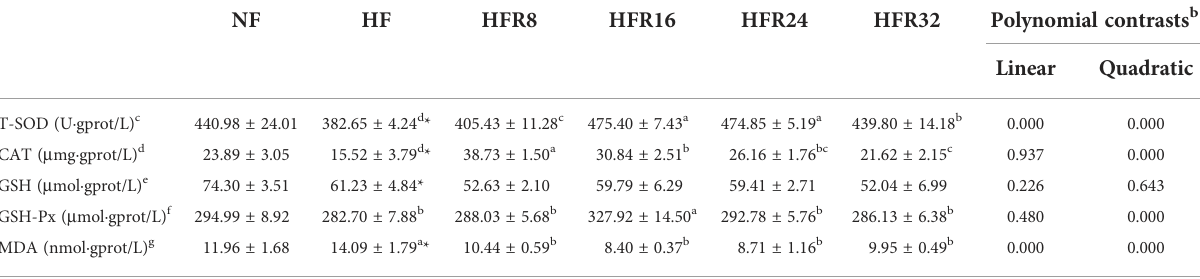
TABLE 4 Effects of resveratrol supplementation on the hepatic antioxidant status in common carp ( Cyprinus carpio ) a . NF HF